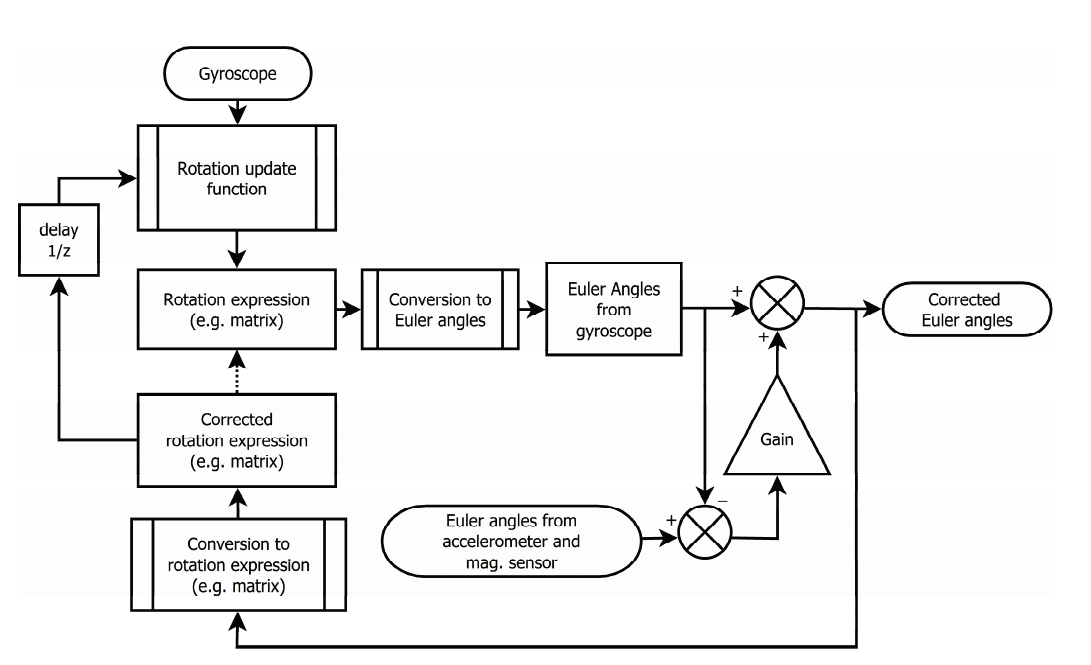
Figure 15. Data fusion of the gyroscope, accelerometer and magnetic